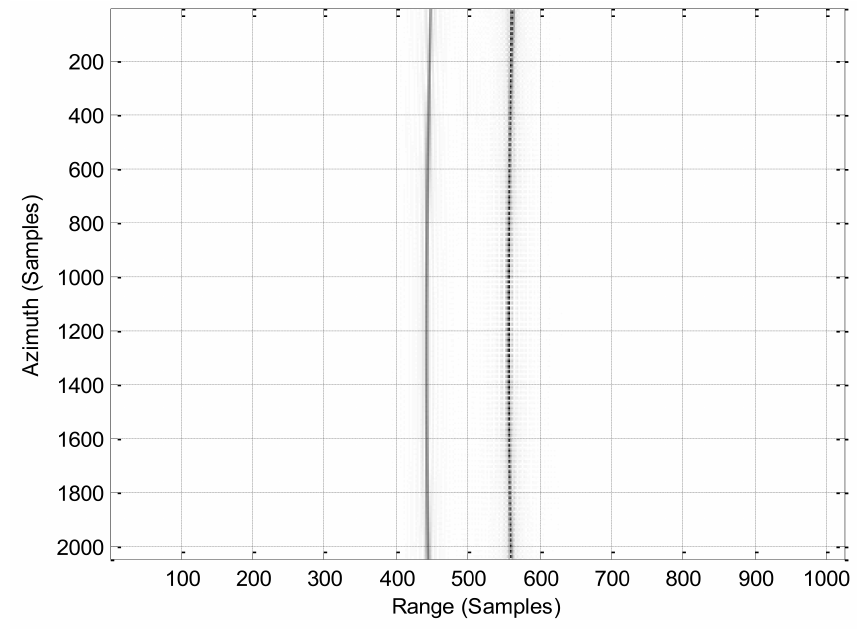
Figure 8. Range-compressed data by MATLAB.